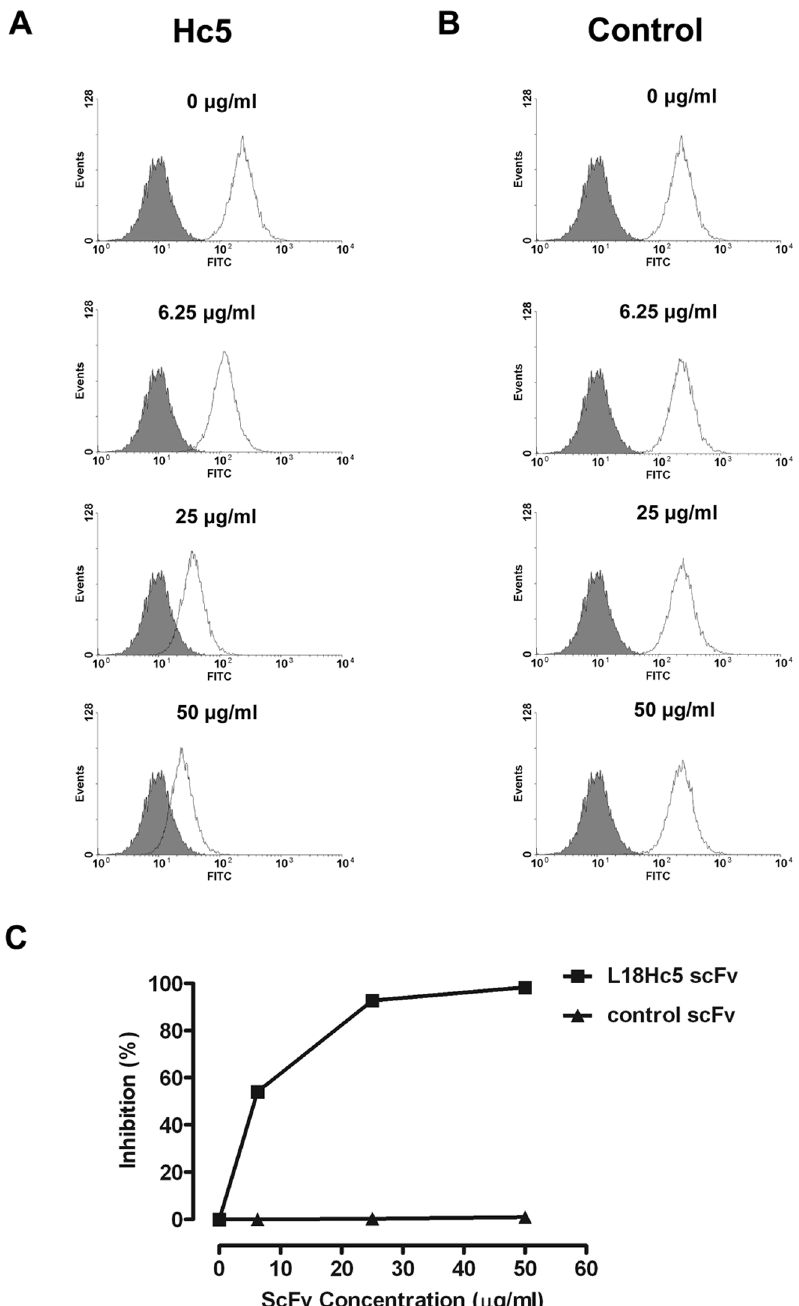
Figure 6. Inhibition of chimeric anti-CD22 MAb binding to CD22 on Raji cells by anti-Id scFv Hc5. Chimeric anti-CD22 MAb at 1 m g/mL was pre-incubated with anti-Id scFv Hc5 or control scFv for 30 min at room temperature. Then the mixtures were incubated with Raji cells (2 6 10 6 ) for 1 h on ice. Following incubation with secondary FITC-conjugated goat anti-human Fc antibody for 1 h on ice, fluorescent intensity of cells was determined by flow cytometry. (A) The histograms showing the distribution of fluorescent intensity of cells that incubated with antibody mixture of SM03 and anti-Id scFv Hc5 (transparent) or blank (solid) at the indicated concentrations. (B) The histograms show the distribution of fluorescent intensity of cells that incubated with antibody mixture of SM03 and a control scFv (transparent) or blank (solid) at the indicated concentrations. (C) The percentage inhibition of anti-CD22 binding by anti-Id scFv Hc5 ( & ) and control scFv ( m ) with data derived from flow histogram of panels (A) and (B). Data shown is a representative of two separate experiments with similar results.